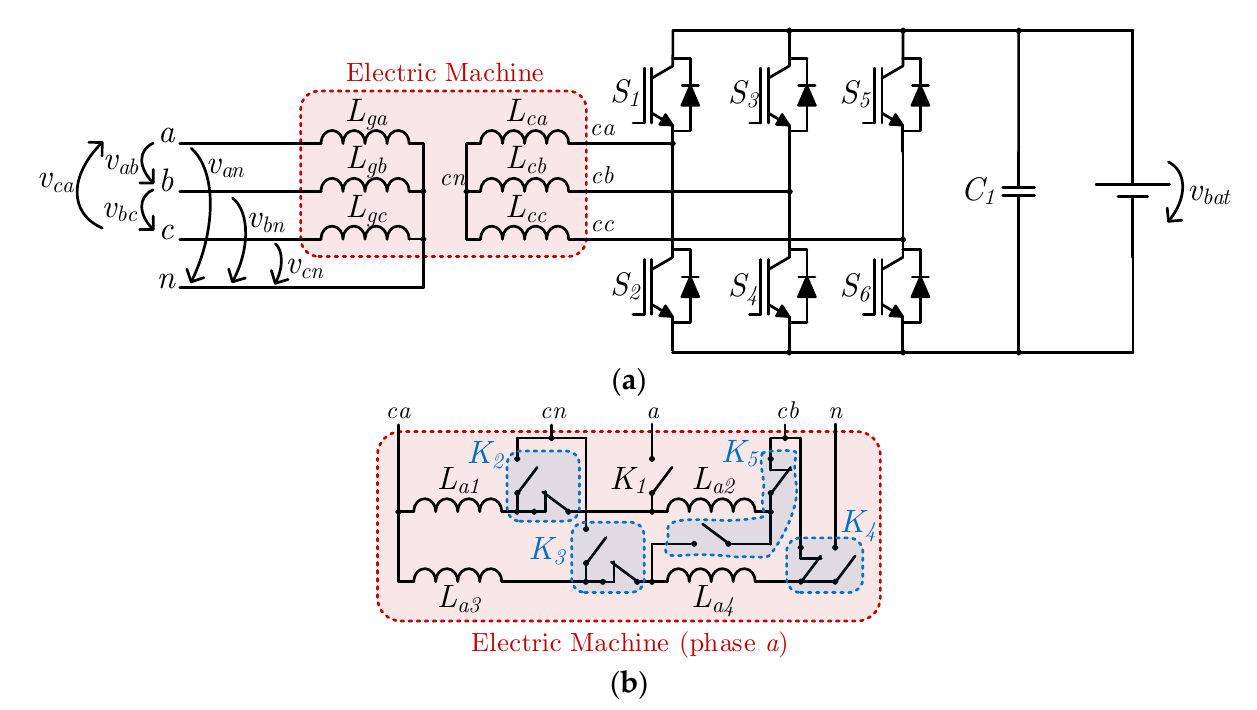
Figure 13. EV IBC with galvanic isolation proposed by S. Haghbin et al. in 2011 [28]: ( a ) topology; ( b ) stator winding arrangement for phase a .